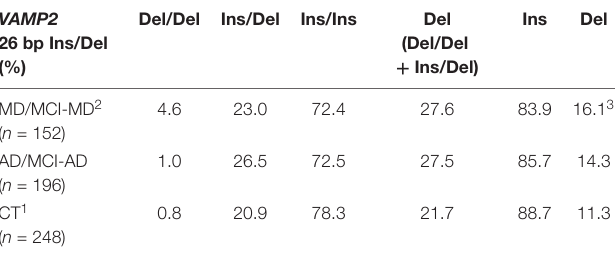
TABLE 3 | Genotypes and allelic distribution of VAMP2 26 bp Ins/Del polymorphism in AD, MD patients and CT subjects. VAMP2 26 bp